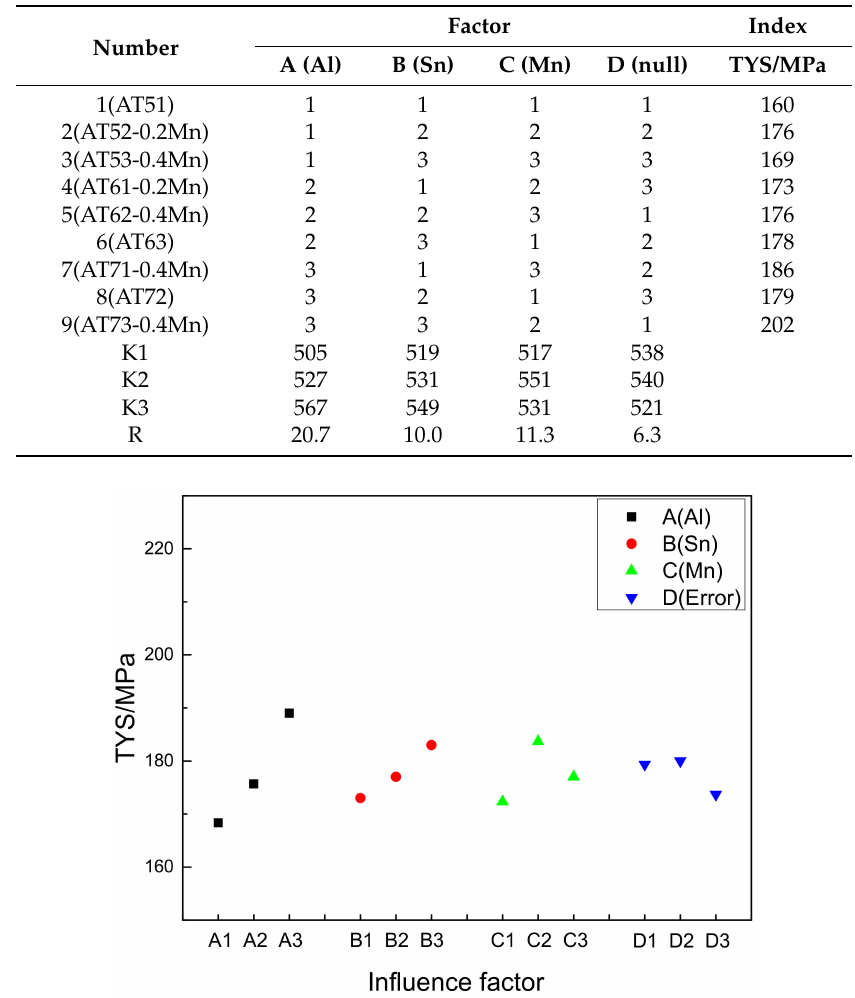
Table 5. Orthogonal test parameters and results analysis table under the tensile yield strength (TYS) index.